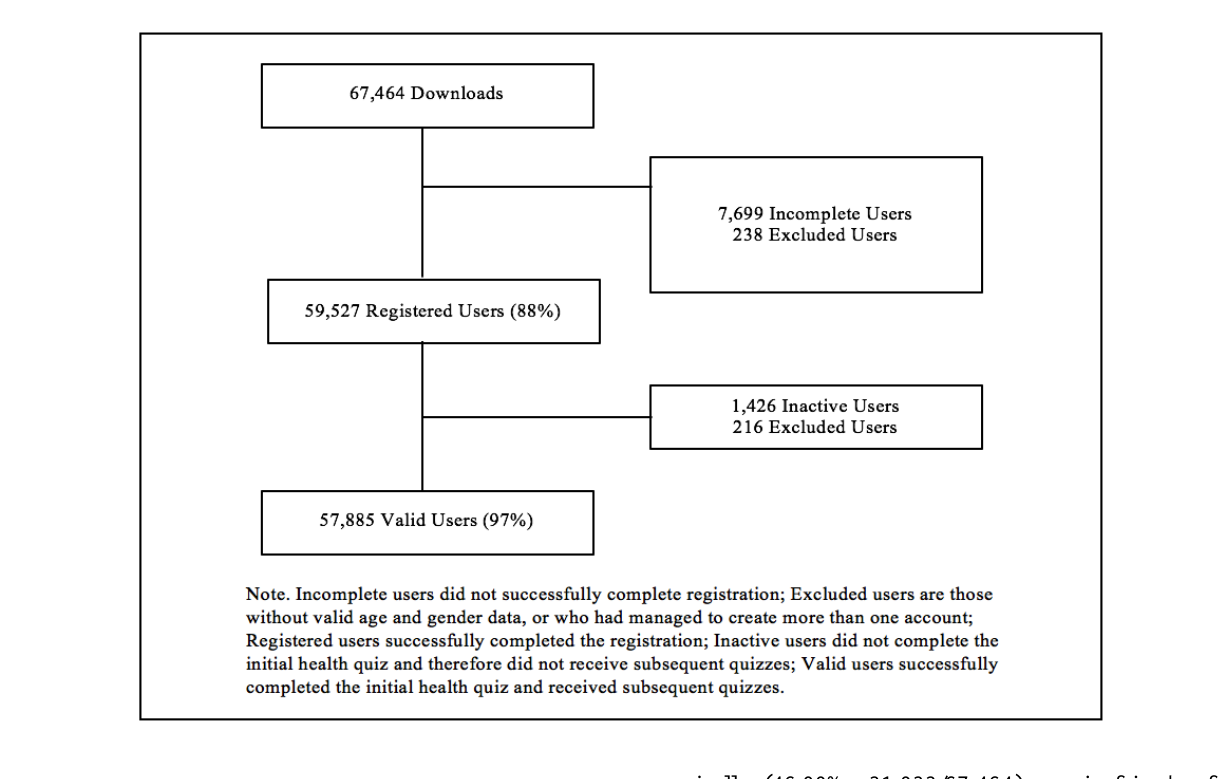
Figure 2. Flowchart of Carrot Rewards app